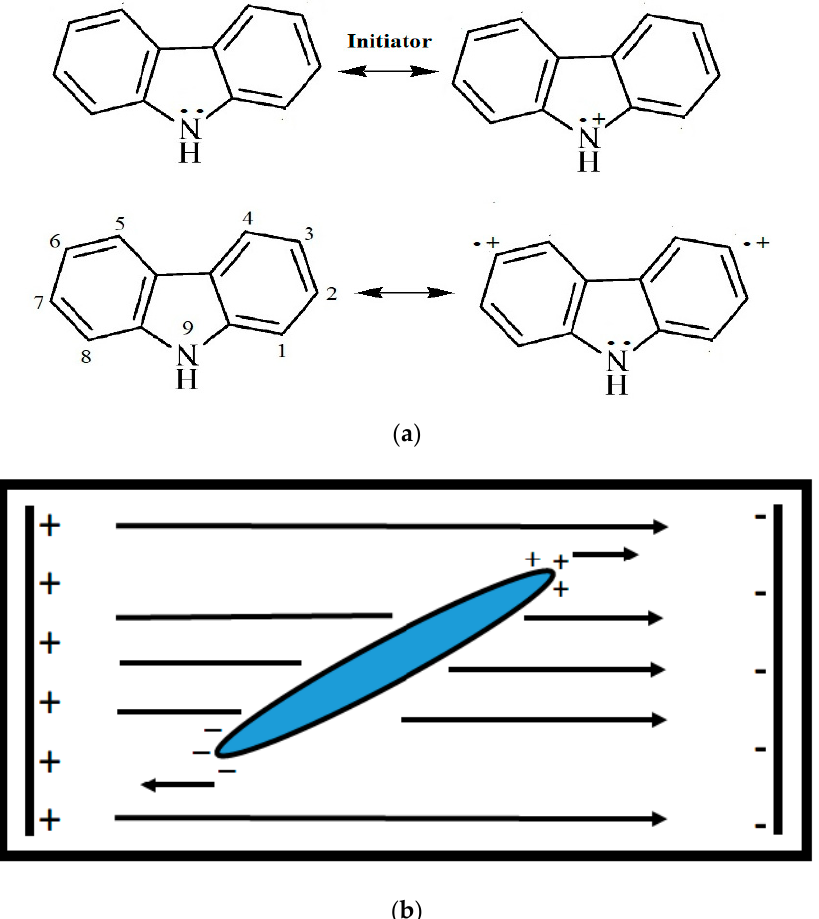
Figure 1. ( a ) Polar intermediate of monomer and ( b ) orientation of a polar monomer in electric field .